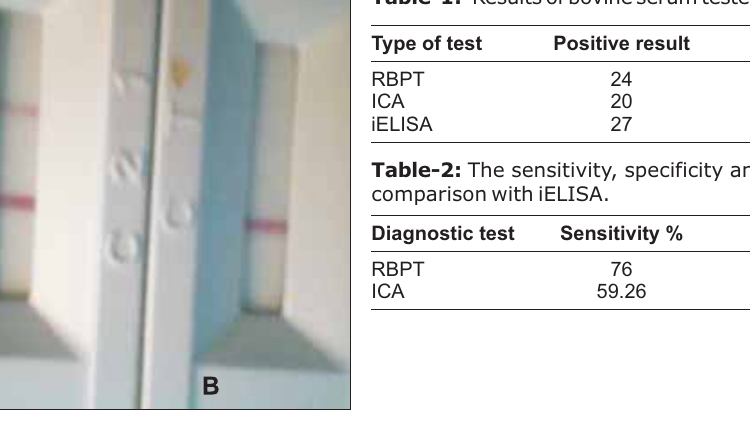
Figure-1: Bovine Brucella Immunochro-matographic assay, positive result , negative result.(A) (B)